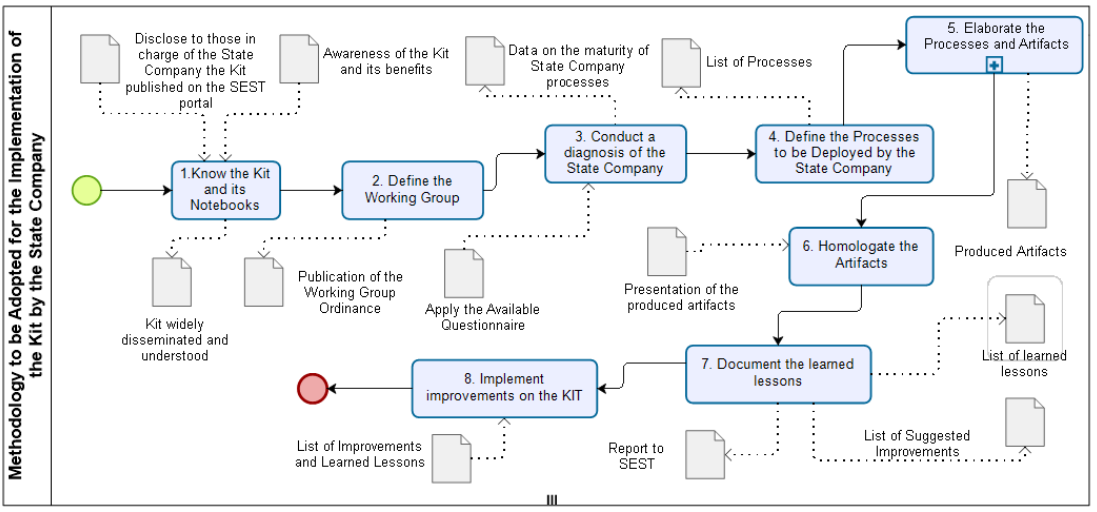
Figure 4. Proposed methodology for the implementation of the ICT Governance Kit.